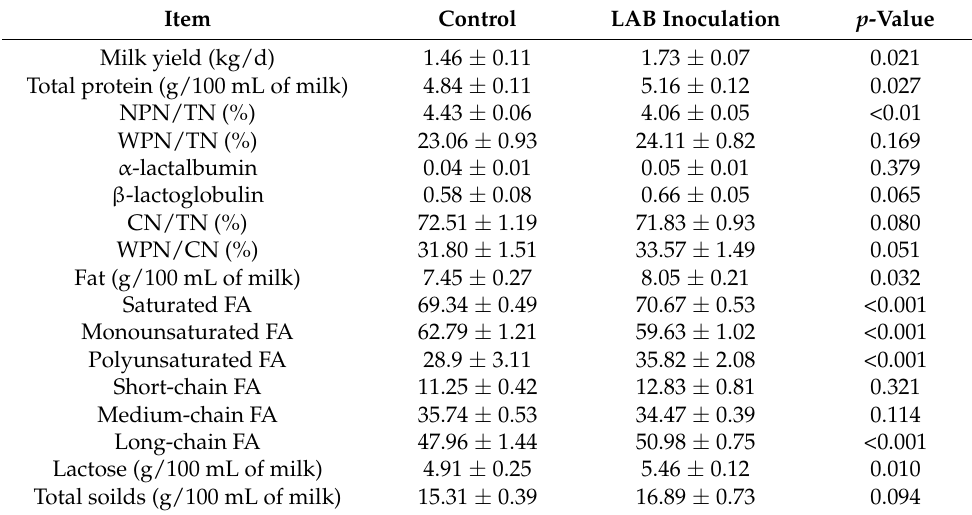
Table 3. Milk yield and basic chemical composition of yaks fed with control and inoculated silages. Item Control LAB Inoculation p -Value Milk yield